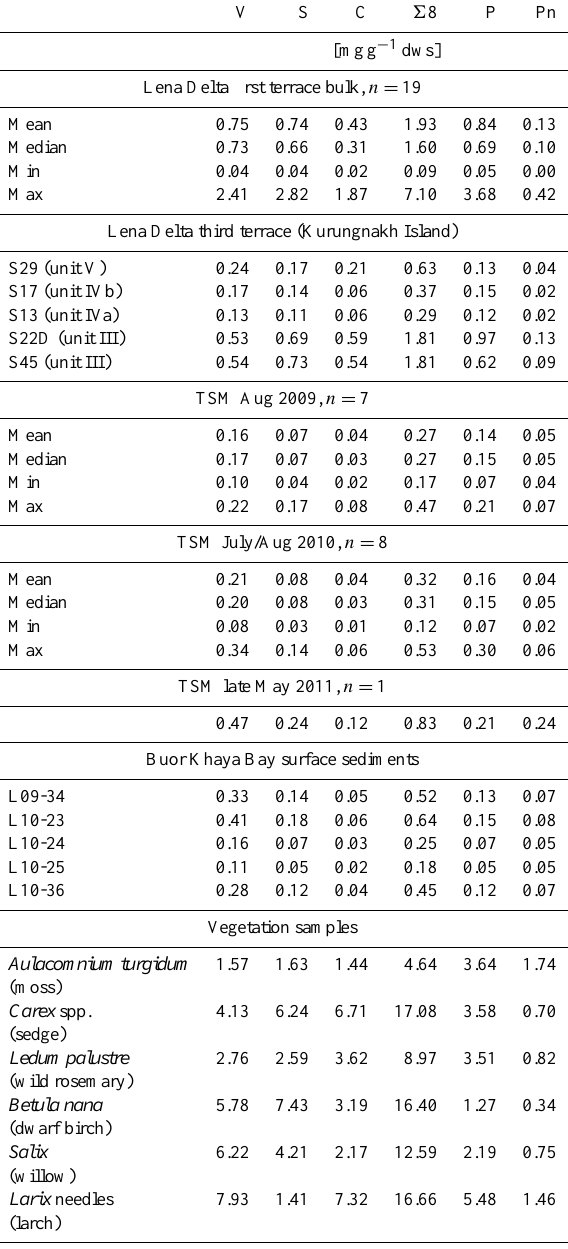
Table 4. Sediment-normalized yields of CuO oxidations products of Lena Delta soils, total suspended matter (TSM), surface sediments, and vegetation samples in milligram per gram dry weight sediment (mgg − 1 dws). Trivial names of analyzed plant species in brackets. V: vanillyl phenols (sum of vanillin, acetovanillone, vanillic acid);